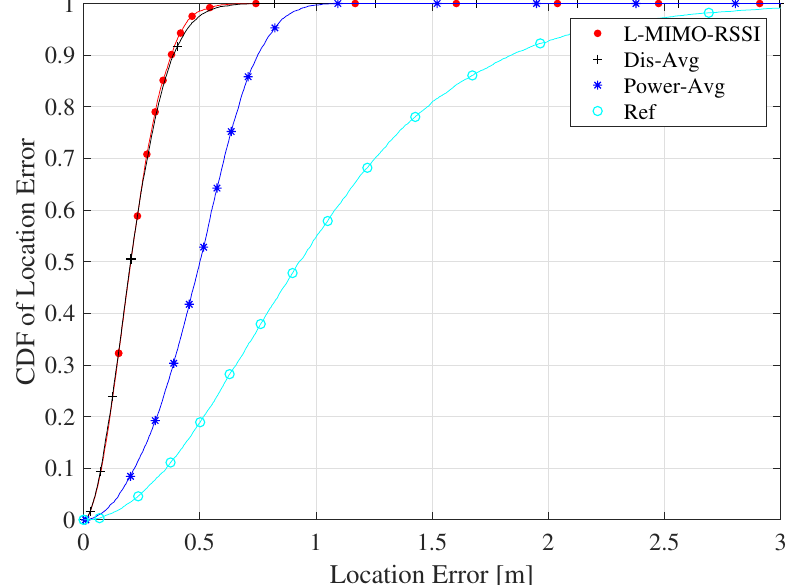
Figure 8. The cumulative distribution function (CDF) of localization root-mean-square error (RMSE) for the proposed algorithms for the line-of-sight (LOS) environment and the co-polarized antenna configuration.